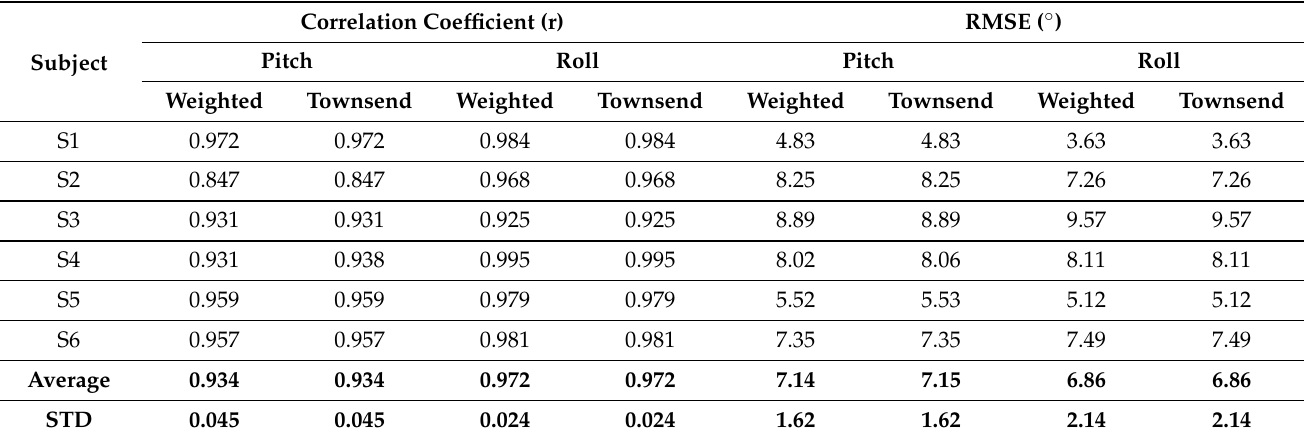
Table 3. Correlation coefficients (r) and root mean squared error (RMSE) from the clinical calibration process. Individual results from each subject is shown along with the bolded summary